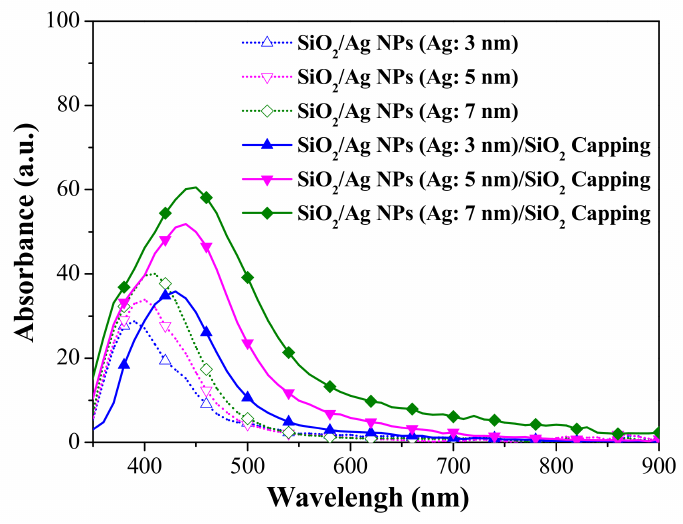
Figure 3. Absorbance spectra of samples with quartz-substrate/SiO 2 -spacer/Ag-NPs/SiO 2 -capping layer.